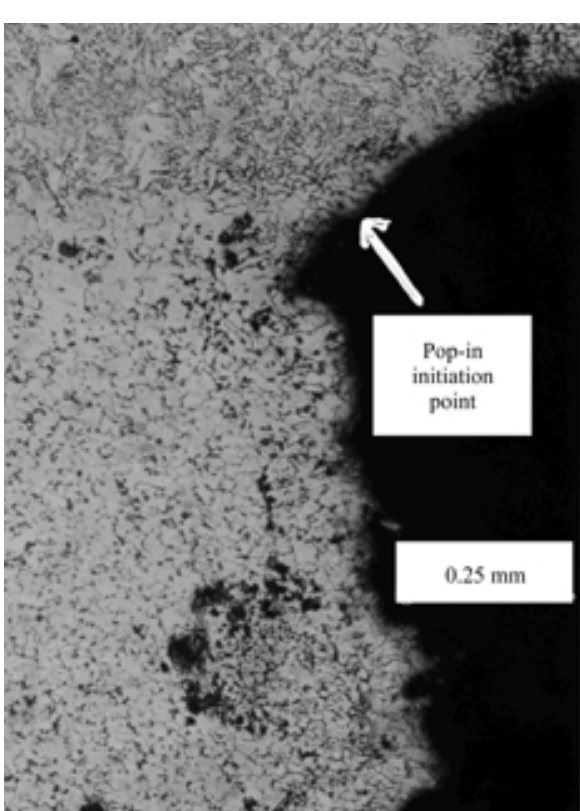
Figure 6a. Micrograph of specimen SE(T) 7 .